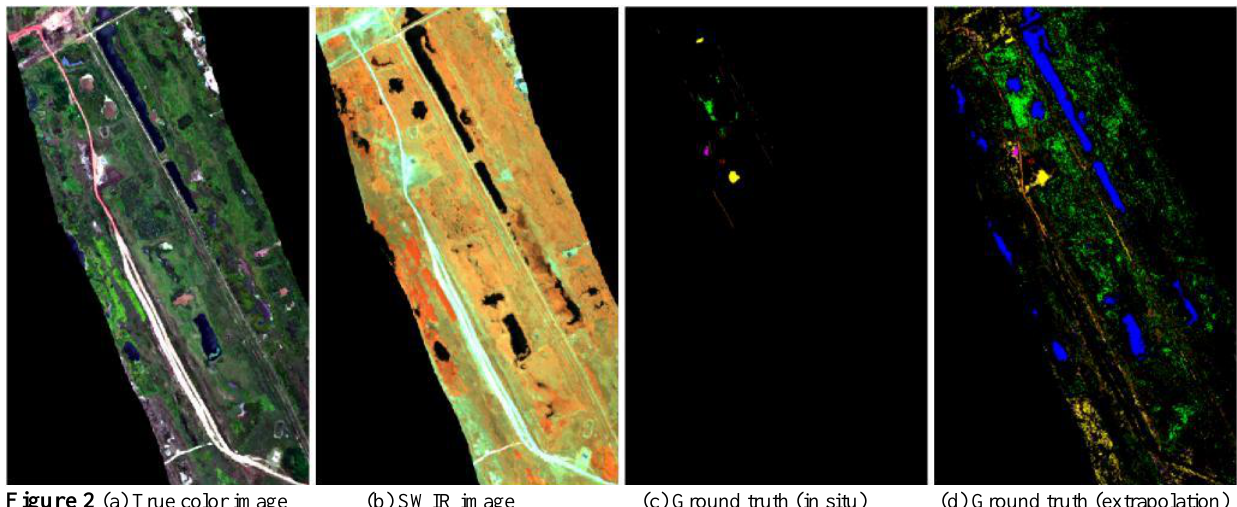
Figure 2 (a) True color image (b) SWIR image (c) Ground truth (in situ) (d) Ground truth (extrapolation) Legend : blue: water, grey: grey sand, orange: laterite, red: concrete, purple: old backwater (north), magenta: old backwater (south), brown: short stressed vegetation and naked soil, yellow: short stressed vegetation, dark green: sparse green vegetation, light green: dense green